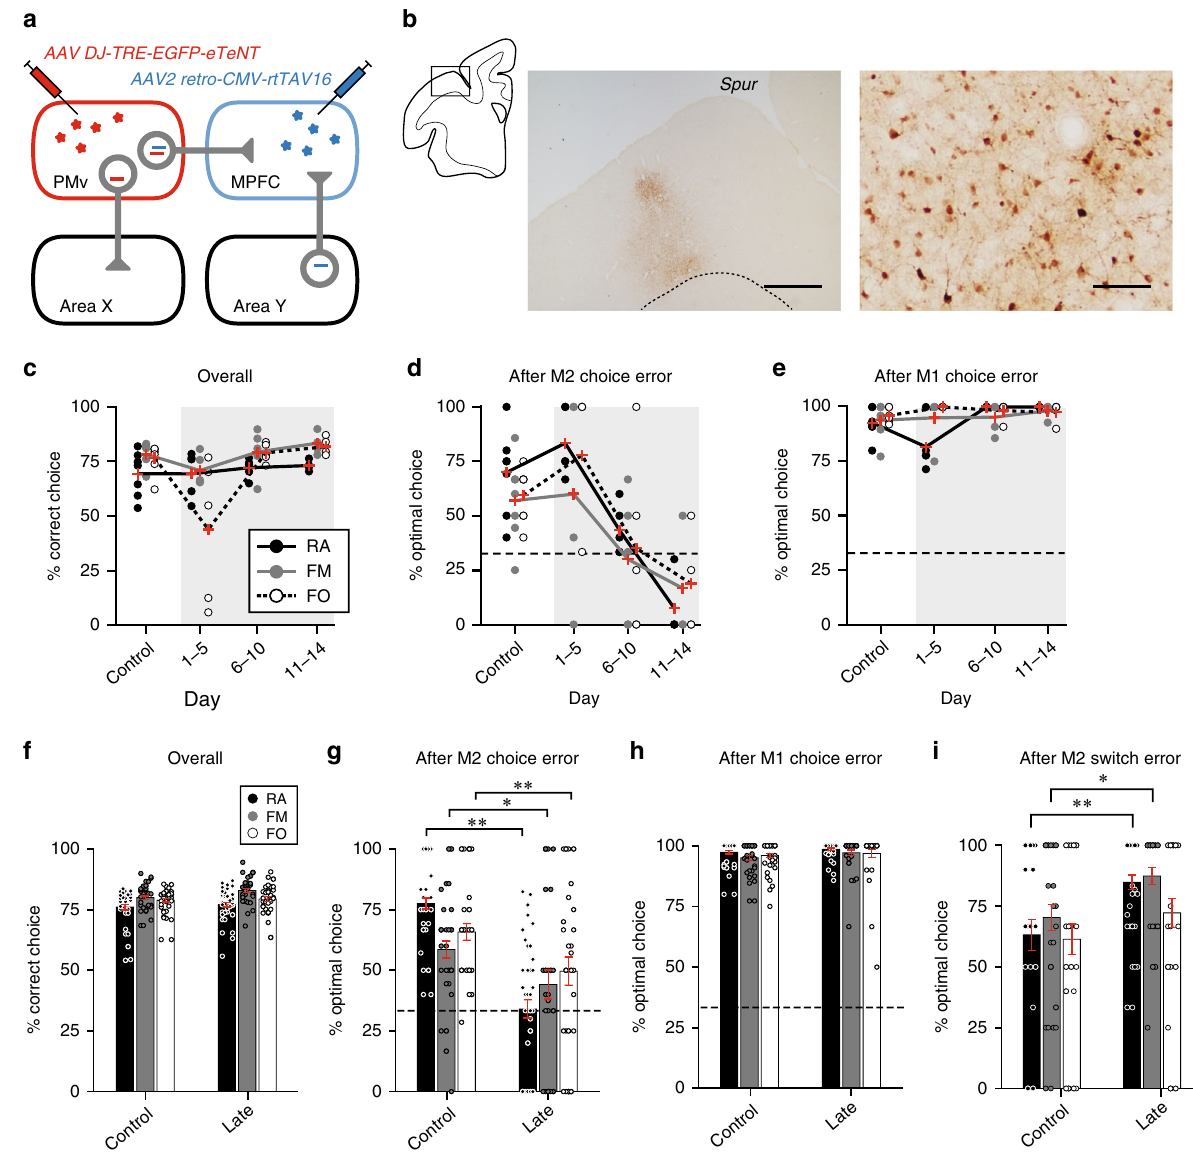
Fig. 6 Task performance after selective blockade of PMv-to-MPFC pathway. a Pathway-selective blockade using double viral vector technique. Only MPFC-projecting neurons in the PMv are double infected (see Methods). b Photomicrographs of a representative injection site in the PMv ( n = 1 animal). Left, distribution of GFP-positive cells, taken from the rectangular area in the coronal section on the left. Dotted line, gray/white matter border. Scale bar, 2 mm. Right, anti-GFP immunostained cells. Scale bar, 250 µ m. Spur, spur of the arcuate sulcus. c – e Performance before (control) and during (shaded